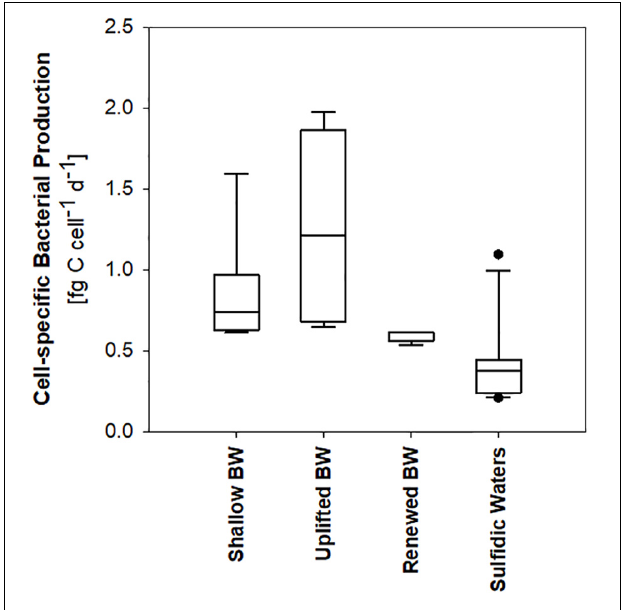
indicating that reactive organic matter derived from ongoing primary production was supplied to heterotrophic communities below the pycnocline. In case of stations OMTF0212 and K1 in the southern Baltic Sea, the low bacterial remineralization of primary production in the surface mixed layer further suggests that labile organic matter was available for bacterial utilization in oxygen-deficient waters ( Table 2 and Figure 3 ). Our estimates, however, do not consider biological processes mediated by non- bacterial heterotrophic plankton and physical processes that may alter the flux of organic matter to deeper waters. These unknown gains and losses may include lateral advection and zooplankton grazing and respiration. On the other hand, there is no direct approach to quantify downward fluxes of fresh organic matter that originates from current primary production. Chemolithoautotrophic Production Dark fixation of CO 2 was determined in selected samples collected at an below the oxycline to assess the potential for the chemolithotrophic fixation of inorganic carbon. Low dark CO 2 fixation of ≤ 2.04 µ g C L − 1 d − 1 was determined in hypoxic samples with oxygen concentrations of 2.55– 127 µ mol L − 1 ( Figure 6A ). Assuming 20% as heterotrophic bacterial growth efficiency, dark CO 2 fixation in hypoxic samples equaled 9–54% of the estimated heterotrophic bacterial carbon demand in the same sample ( Figure 6B ). Substantially higher dark CO 2 fixation of 3.89–25.46 µ g C L − 1 d − 1 Z . M was determinded at oxygen concentrations ≤ 2.26 µ mol L − 1 , with maxima determined in anoxic samples containing sulfide concentrations of 1.41–3.70 µ mol L − 1 ( Figures 6A,B ). Overall, dark CO 2 fixation was positively correlated to ammonium concentrations ( Figure 6C